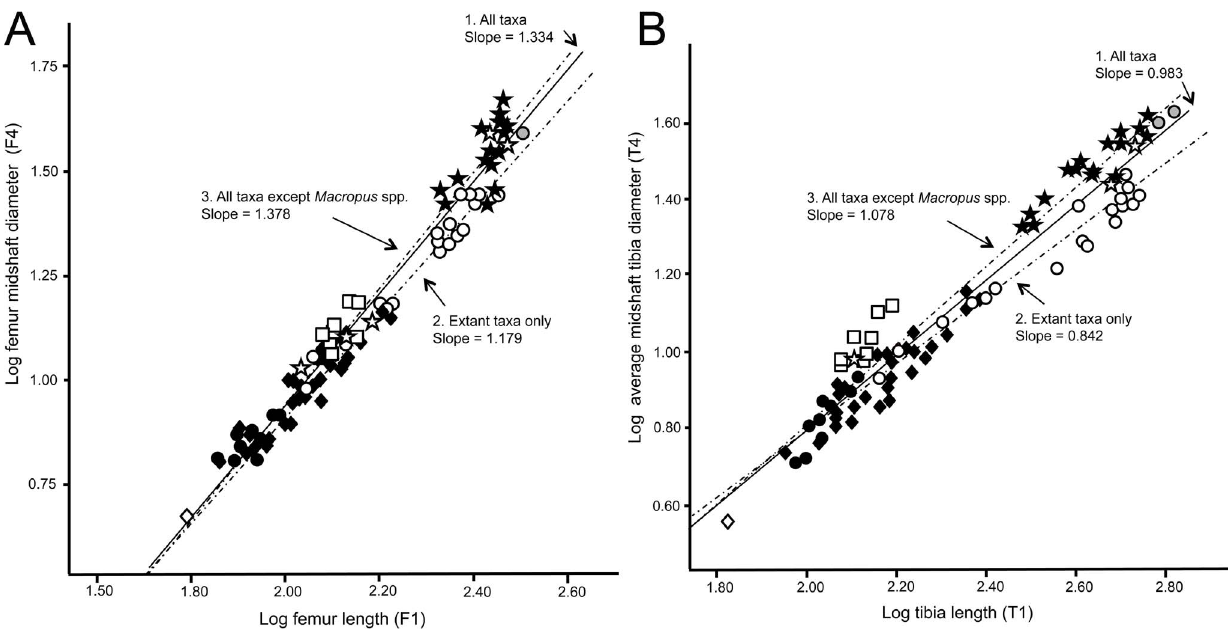
Figure 10. Scaling of long bone length versus diameter (i.e., robusticity). (A) Femur length versus average femur cross-sectional diameter (B) Tibia length versus average tibia midshaft cross sectional diameter. The regression line and its 95% confidence interval (dotted lines) are also shown (A r 2 =0.96, B r 2 =0.933). Key: Open diamond = Hypsiprymnodon moschatus ; filled circles = potoroines; open circles = extant species of Macropus ; half tone circles = extinct (‘‘giant’’) species of Macropus ( M. titan or M. ferragus ); filled diamonds = extant macropodines (other than Macropus or Dendrolagus ) and lagostrophines; open squares = species of Dendrolagus ; filled stars = sthenurines; open stars = other extinct taxa. The regression line and its 95% confidence interval (dotted lines) are also shown.